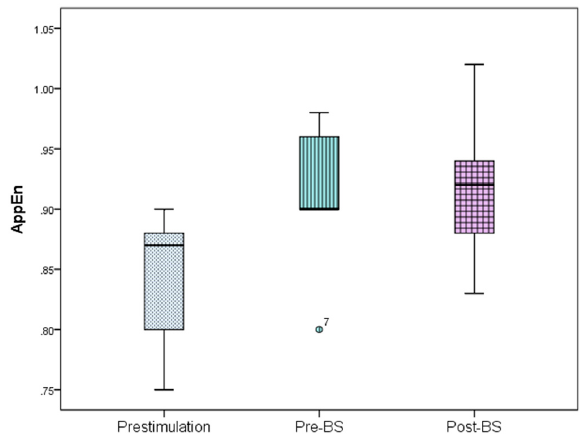
Figure 5. Approximate entropy (AppEn) variation for the prestimulation, pre-BS, and post-BS periods. Error bars represent standard deviation. One-way ANOVA analysis revealed no statistical significance between these periods ( p > 0.05). BS—burst suppression.